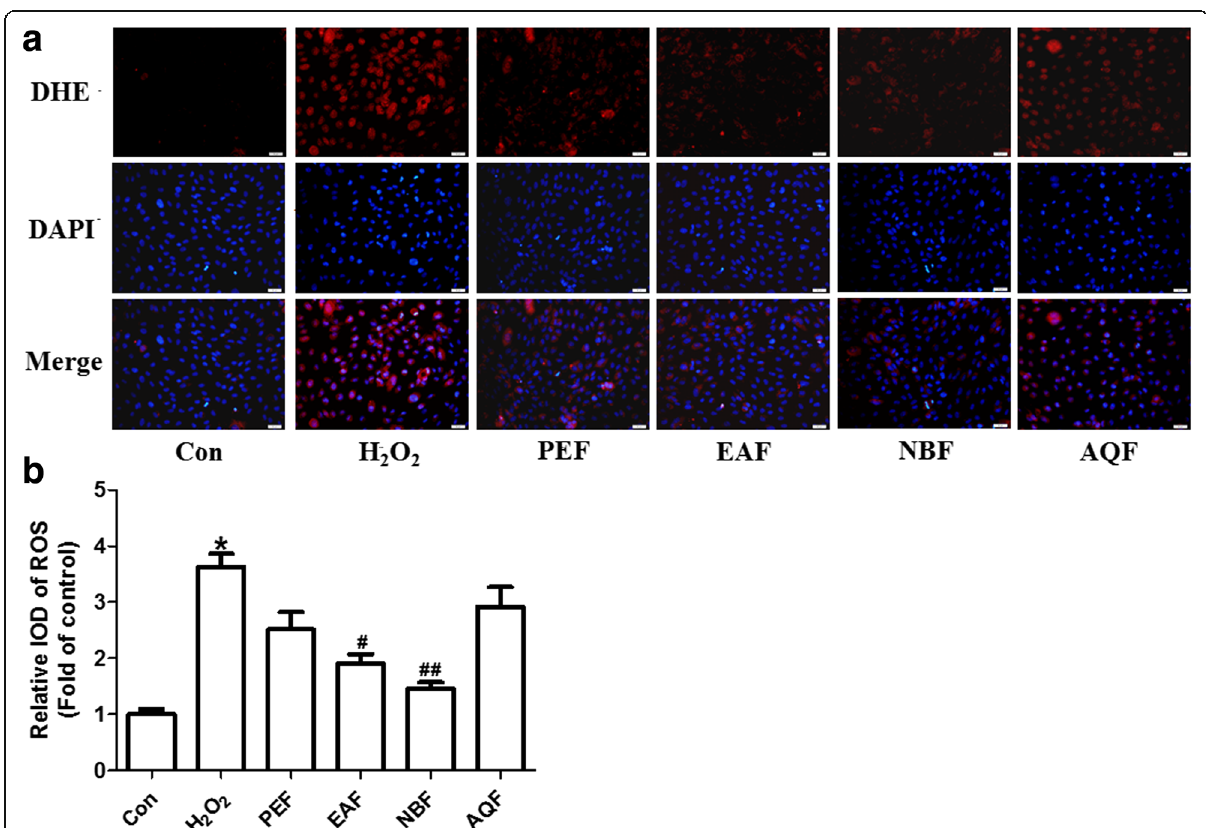
Fig. 2 Effects of the four extract fractions on vascular reactive oxygen species (ROS) production in HUVECs. a The top panel shows representative images of DHE-stained cells, which fluoresce red owing to ROS-mediated oxidation of DHE to ethidium. The middle panel shows representative images of DAPI-stained nuclei that fluoresce blue. The bottom panel shows the merged fluorescence images (× 400 magnification). b Quantitative analysis of DHE fluorescence intensity. The average DHE fluorescence intensities were normalized to the fluorescence intensity of DAPI. All data are expressed as mean ± SEM. n = 6. *P < 0.05 vs. control. # P < 0.05 and ## P < 0.01 vs. H 2 O 2 alone. Con: control; PEF: petroleum ether fraction; EAF: ethyl acetate fraction; NBF: n-butanol fraction; AQF: aqueous